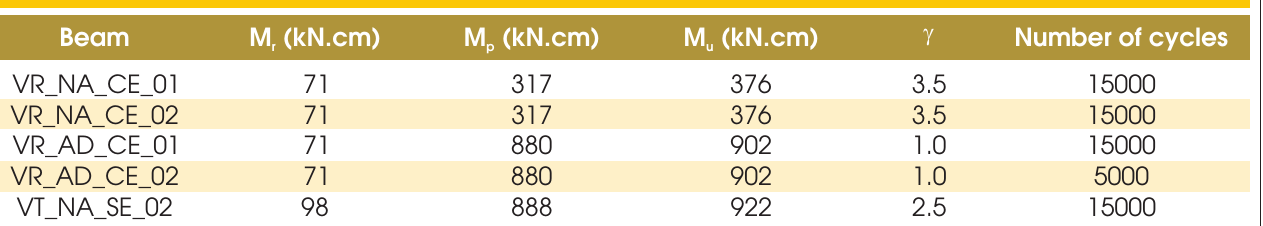
Table 3 – Numerical model parameters and number of cycles analyzed